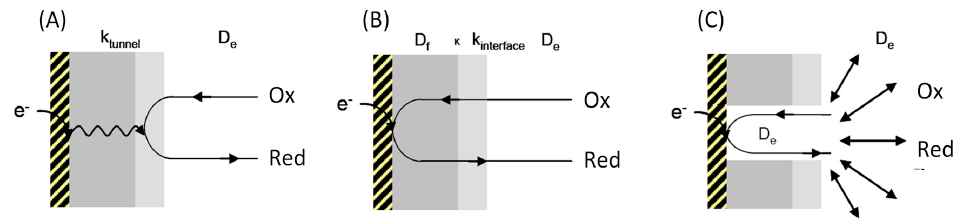
Figure 5. ET processes through a self-assembled monolayer (SAM) (in grey) formed on an electrode. ( A ) Tunneling ET process through a compact SAM; ( B ) ET through a SAM behaving as a membrane. ET will be controlled by a partition coefficient at the membrane/solution interface and by the diffusion coefficient inside the membrane; ( C ) ET proceeds through defects in the SAM. D e and D f are the diffusion coefficients in the electrolyte and in the SAM, respectively. Ox and Red designate a redox couple in solution. Adapted from [96].